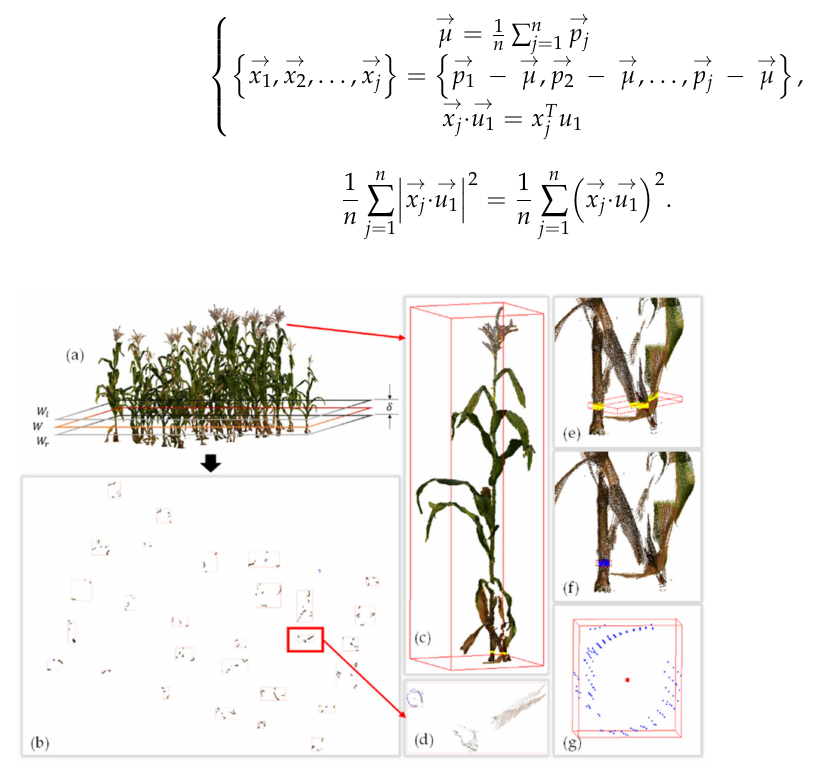
Figure 4. Effect of the coordinate calibration of the Maize-04 plant. ( a ) Schematic diagram of point cloud slicing algorithm. ( b ) Top view of sliced maize plant in field; ( c ) Maize-04 -No. 9; ( d ) Slice of Maize-04 -No. 9; ( e ) 3D view of slice; ( f ) 3D view of stalk slice; ( g ) Stem spatial positioning points of Maize-04 -No. 9. The blue point cloud show the slice point cloud of maize stalk obtained by fitting from the slice point cloud. The red point cloud is the center of the fitting circle. That’s where the maize stalks